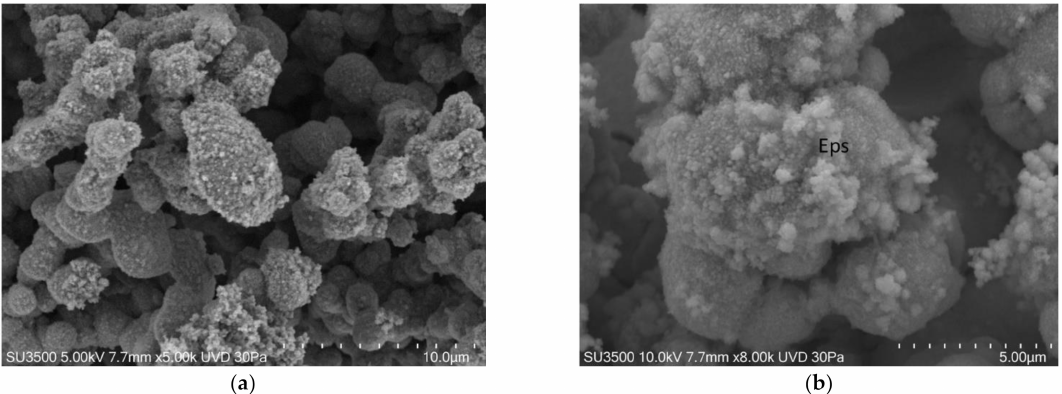
Figure 4. S. mutans prepared by conventional variable pressure SEM (VP-SEM) procedure. ( a ) VP-SEM 5000 × . Bacterial towers are lined by a superficial granulation representing Eps secretion. Image was captured from the same sample observed in [50] Figure 2f. ( b ) VP-SEM 8000 × . On S. mutans cells surface is clearly visible the fine graininess of freshly secreted Eps components. Image is the same of [50] Figure